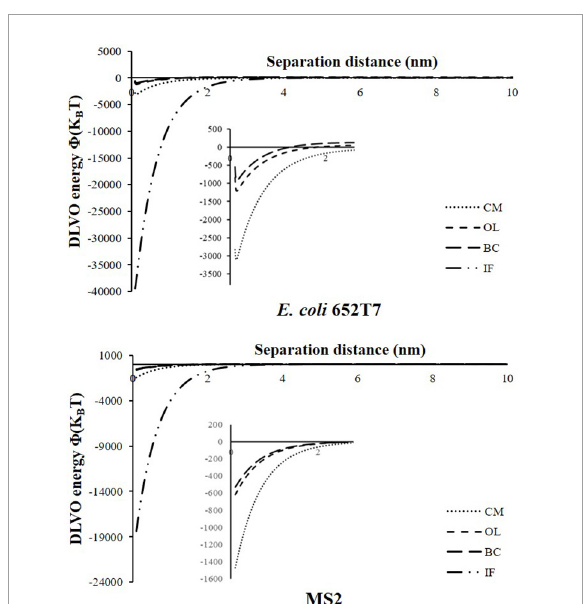
Zhang and Zhang, 2015; Jiang et al., 2018). E. coli 652T7 and